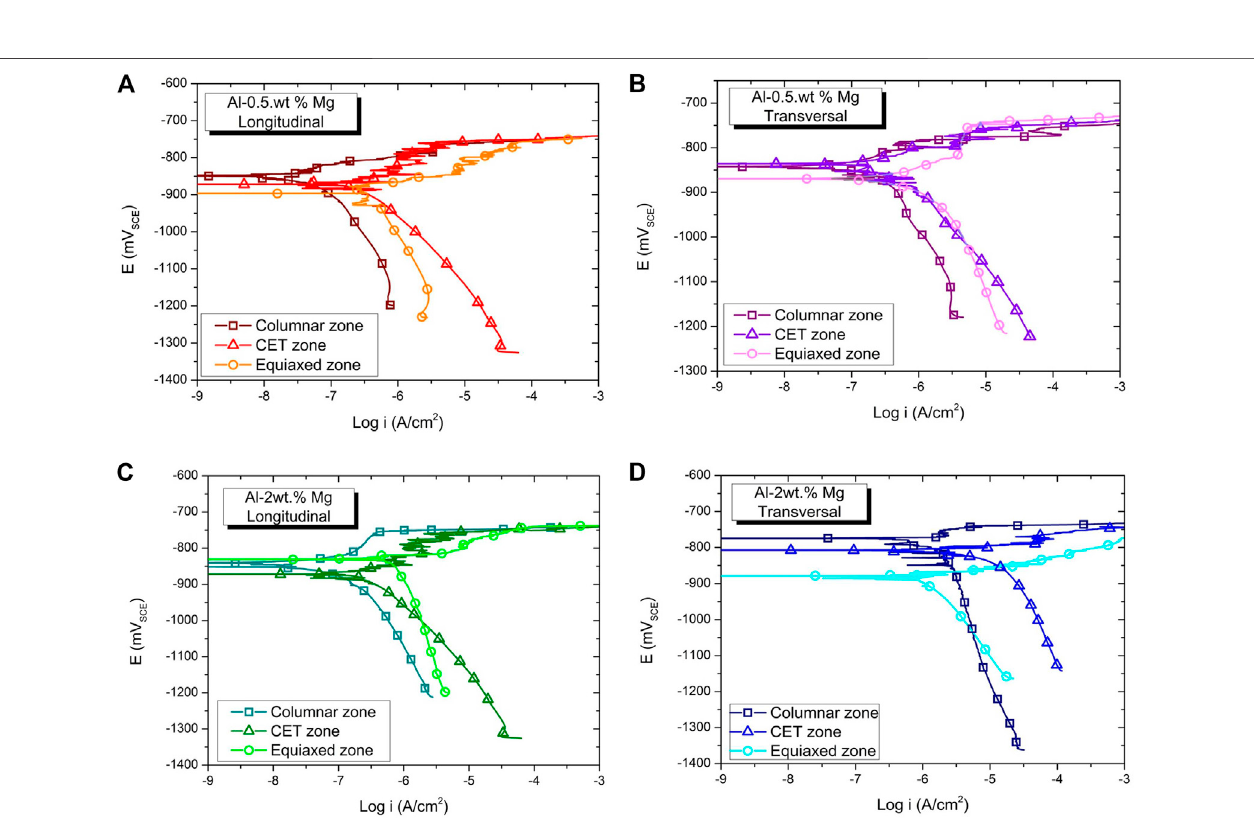
Frontiers in Materials |